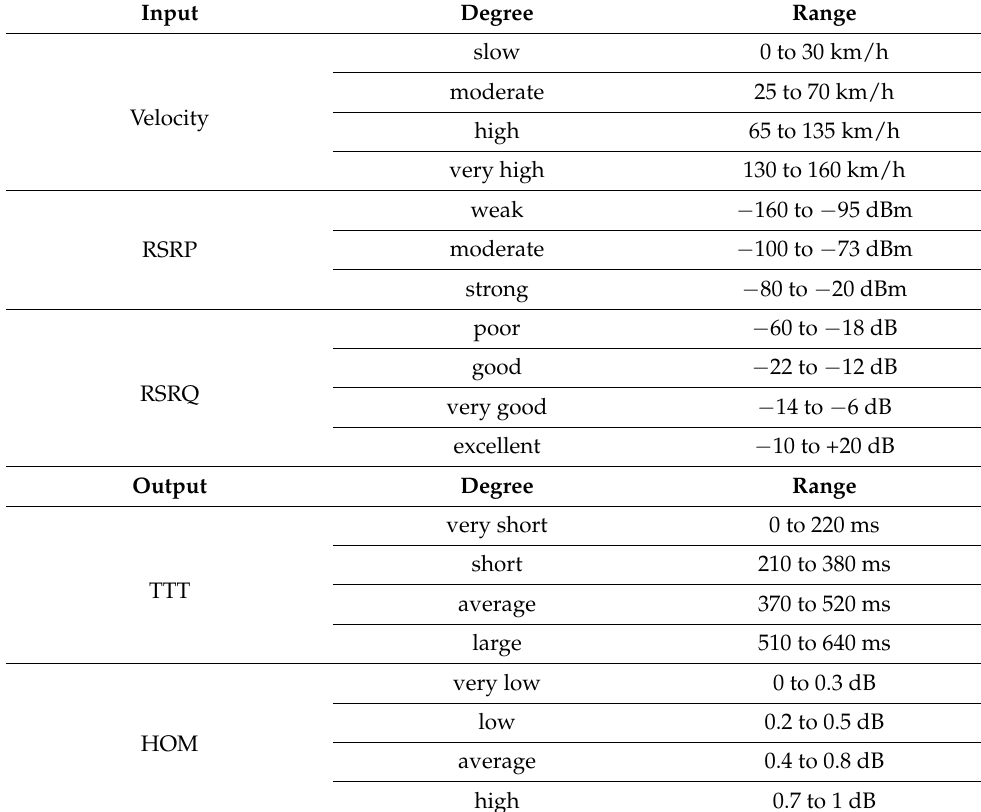
Table 2. Membership values for input and